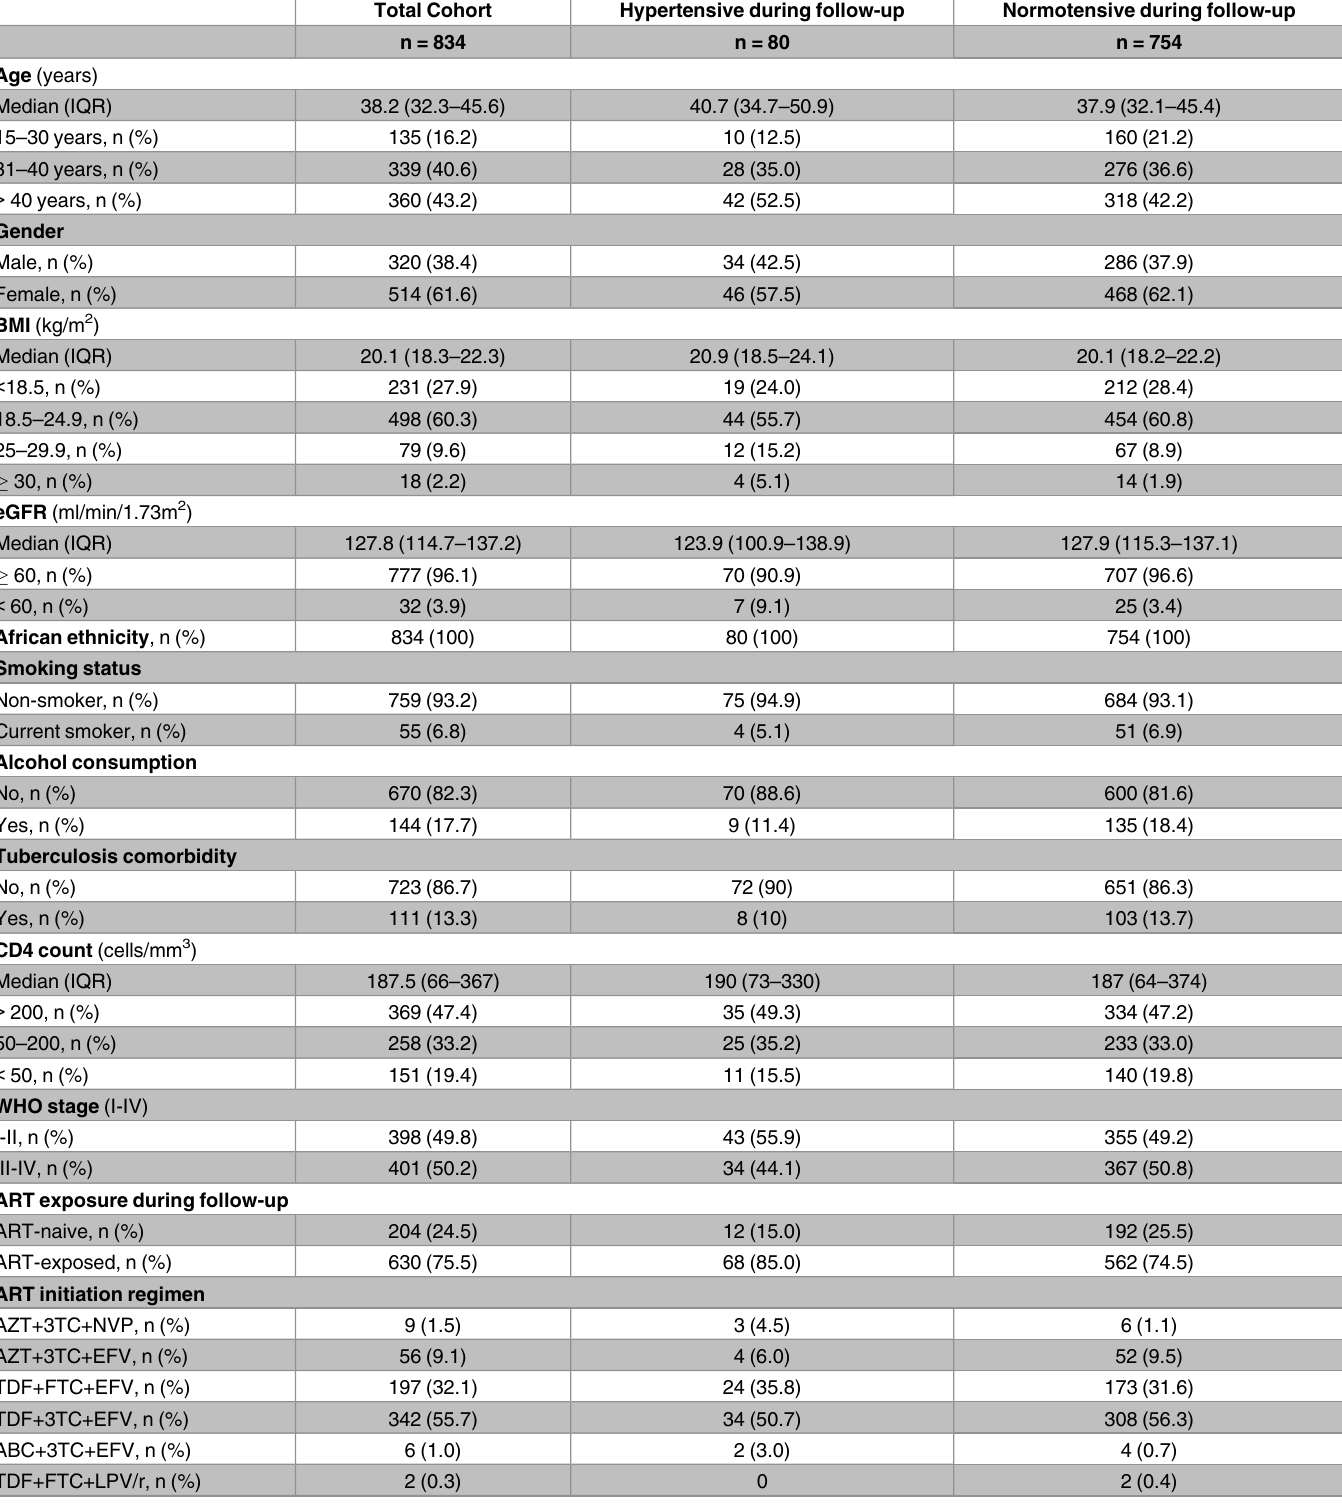
Table 1. Summaryof patient baseline characteristics according to the development of